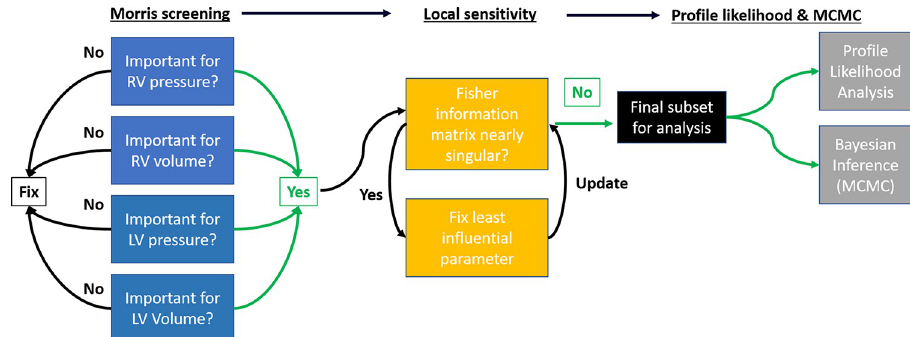
Fig 3. Workflow schematic. The initial set of 49 parameters is reduced to 38 due to apriori parameter fixing. Morris screening is used to confirm which parameters are on average the most influential on the four model outputs. This reduces the parameter set from 38 to 17 parameters. A local sensitivity analysis using the different experimental designs as the quantities of interest is used to determine if any parameters show local interdependence in their sensitivities, which suggests possible practical non-identifiability. If the Fisher information matrix constructed from the model sensitivity is ill-condition, the least influential parameters of the subset are fixed. This reduces the parameter subset from 17 parameters to a set of 13 parameters. Lastly, the parameters and experimental designs are subjected to profile likelihood analysis and MCMC to test for practical